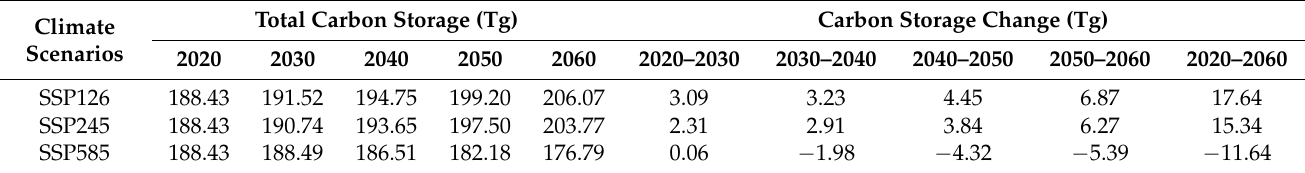
Table 5. Carbon storage dynamic changes in forest ecosystems under different scenarios during the period of